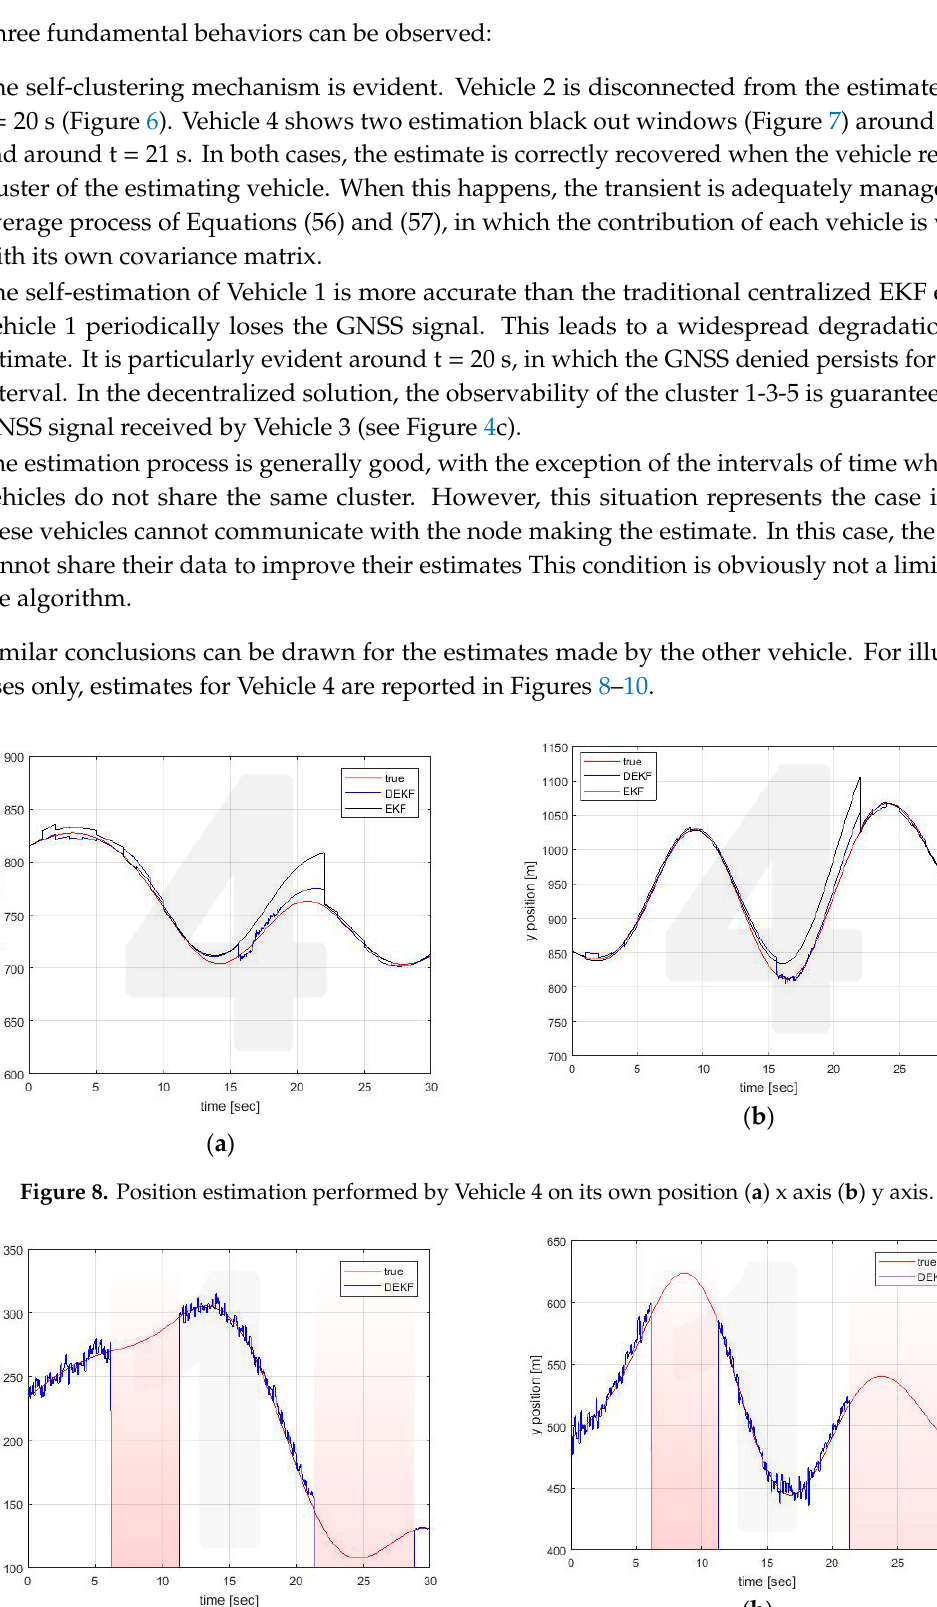
Figure 9. Position estimation performed by Vehicle 4 on Vehicle 1 position ( a ) x axis ( b ) y axis.